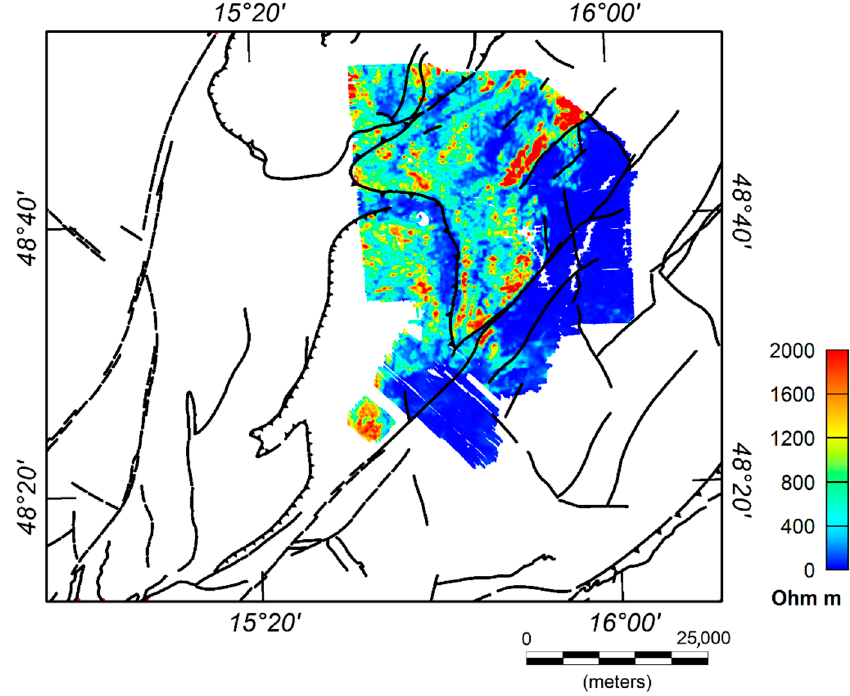
Figure 5. Aero-electromagnetic resistivity map of the study area. The main maxima, with amplitude of about 1500–2000 Ohm m, are correlated with the known faults and are located in the central and western sectors of the survey area. The region of minima (dark blue) coincides with the extent of the Neogene Molasse basin and the location of smaller sedimentary basins within the Bohemian Massif.